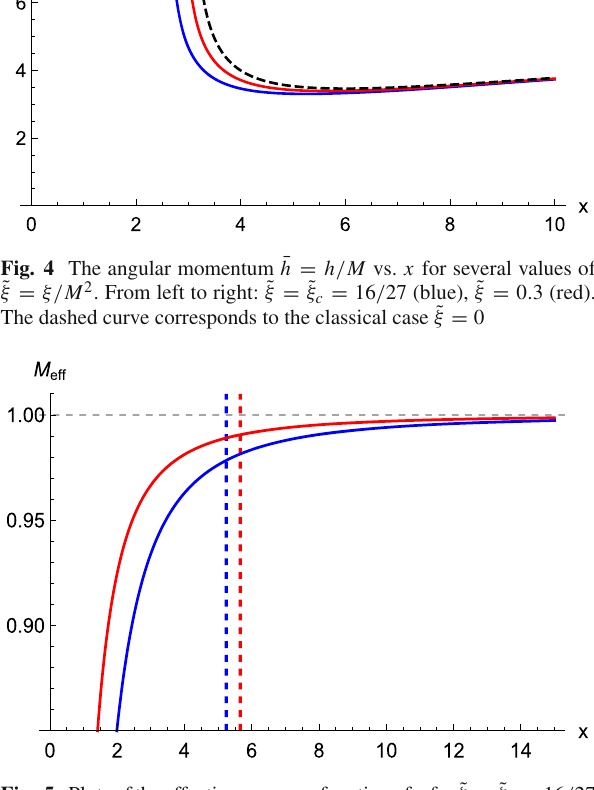
Fig. 5 Plotsoftheeffectivemassasafunctionof x for ˜ ξ = ˜ ξ c = 16 / 27 (blue) and ˜ ξ = 0 . 3 (red). The vertical dashed lines indicate the ISCO for the same values of ˜ ξ ,